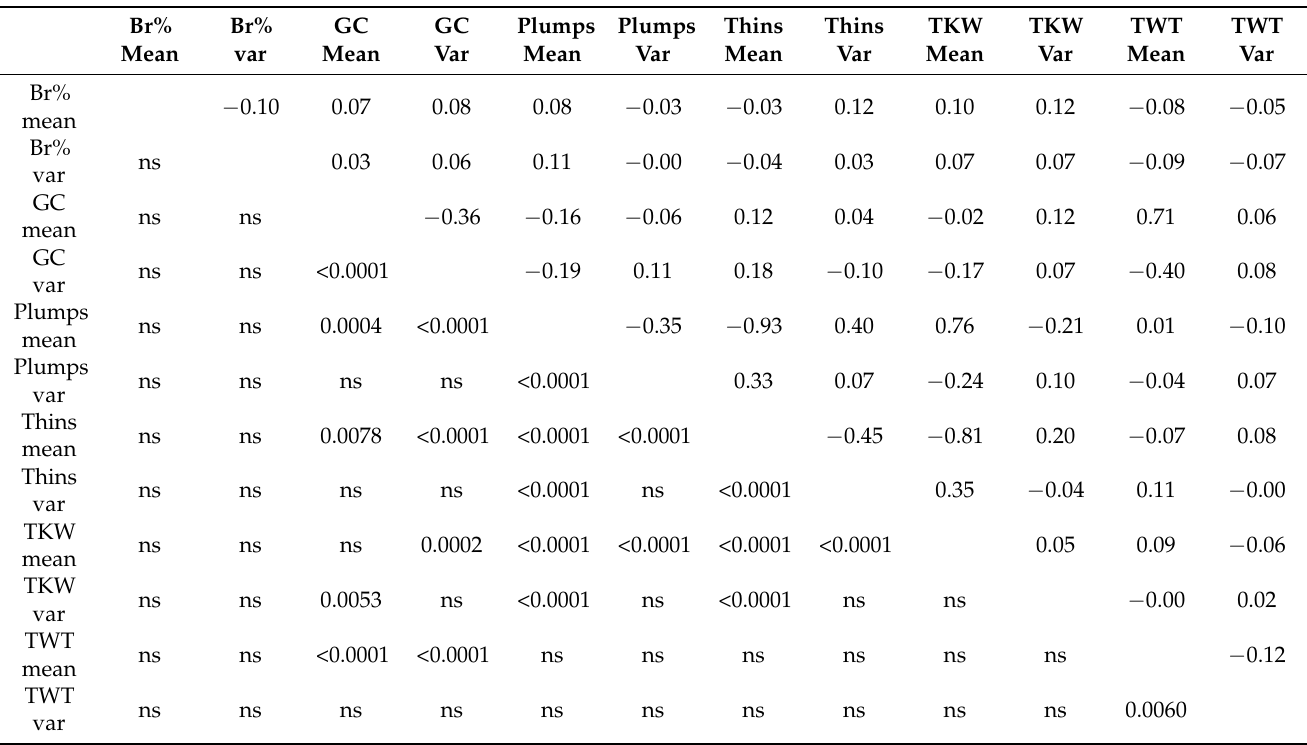
Table 2. Pearson phenotypic correlation coefficients for pairwise comparisons of milling quality trait means and variances (upper cells) with corresponding Prob > |r| (lower cells) for correlations with p -values ≤ 0.01.